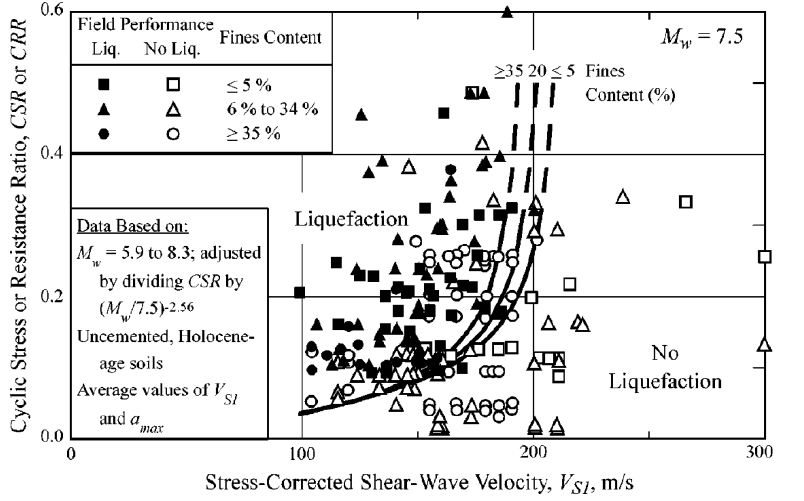
Figure 6: Liquefaction resistance CRR- V s curves by Andrus and Stokoe [23] for magnitude of 7.5 Richter